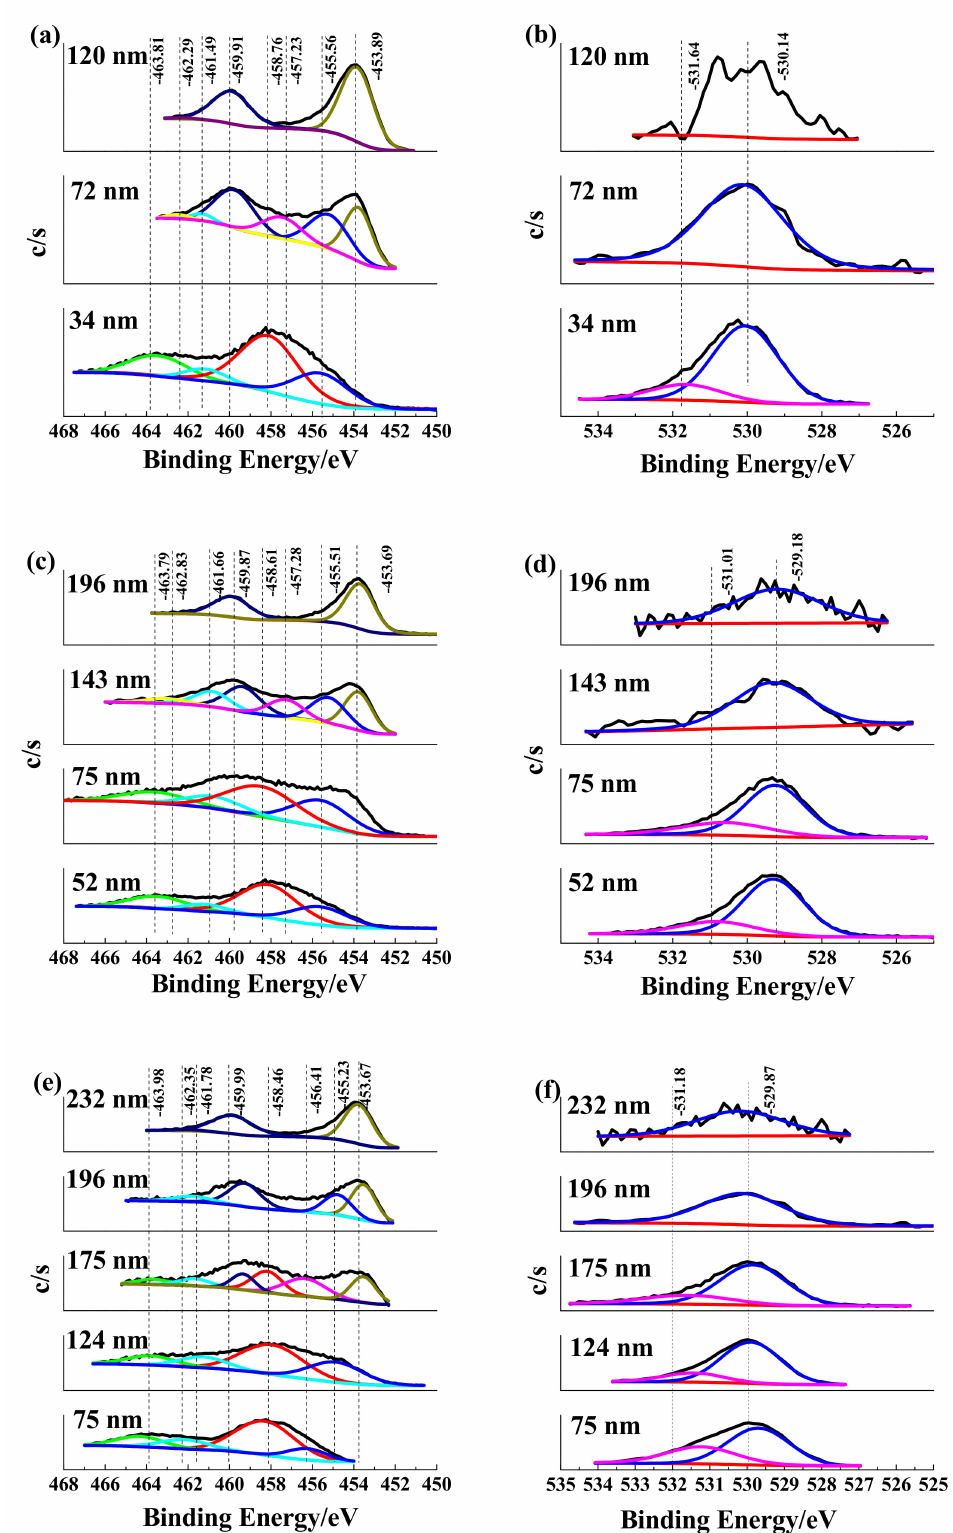
Figure 7. High-resolution XPS spectra of Ti 2p and O 1s obtained from Ti 10 , Ti 30 , and Ti 50 . ( a , b ) Ti 10 ; ( c , d )Ti 30 ; ( e , f )Ti 50